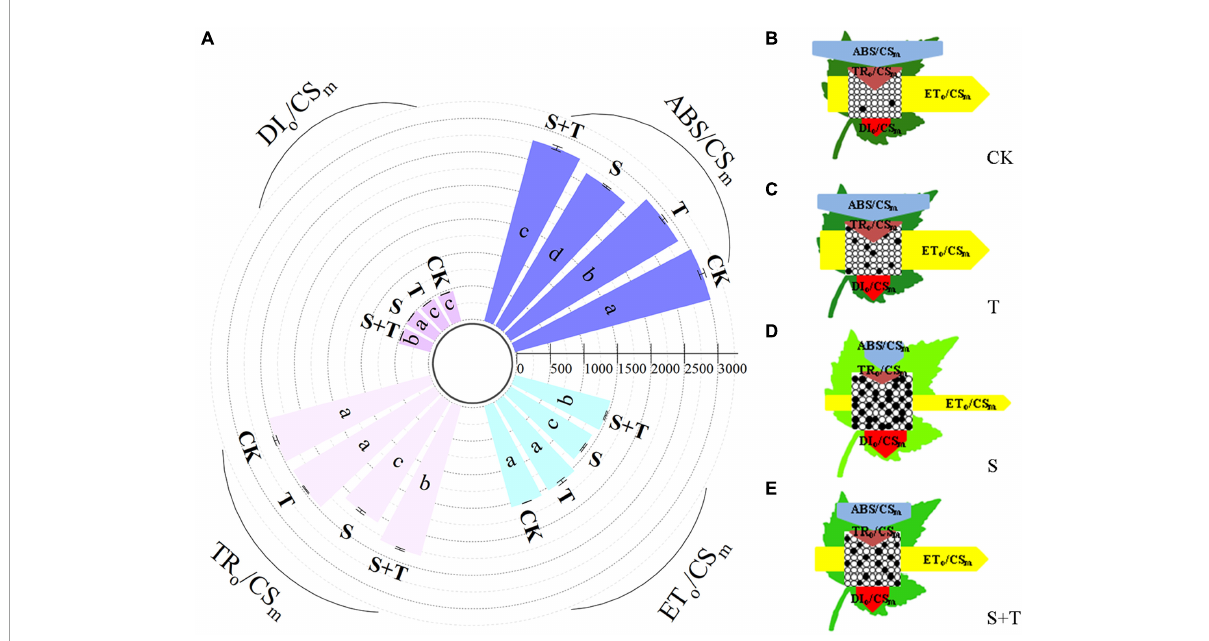
FIGURE6 Effects of Tre treatment on phenomenological fluxes (per cross-section, CS m ) of tomato seedlings exposed to salt stress for 5 d. (A) Electron absorption, capture, transport and dissipation flux per cross-section. The results showed the mean ± SE of three replicates, and the different letters denote the significant difference among treatments ( P < 0.05), according to Duncan’s multiple tests. (B–E) Energy pipeline leaf model of phenomenological fluxes (per cross section, CS m ) in CK, T, S, and S+T, respectively. Changes in each energy flux were indicated by resizing the corresponding arrows. Empty and full black circles showed the percentages of active and non-active reaction centers of photosystem II (PSII), respectively. CK, control; T, 10 mM Tre; S, 150 mM NaCl; S+T, 150 mM NaCl + 10 mM